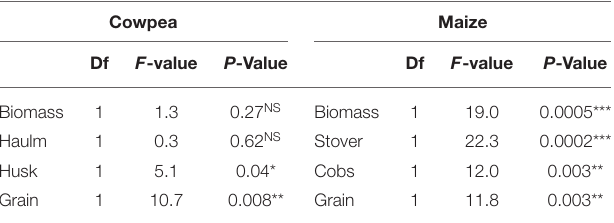
TABLE 4 | Analysis of variance (ANOVA) results [degrees of freedom (df), F-value, P -value] for differences between sub-surface water retention technology (SWRT) plots and control plots in performance indicators of cowpea and maize at crop